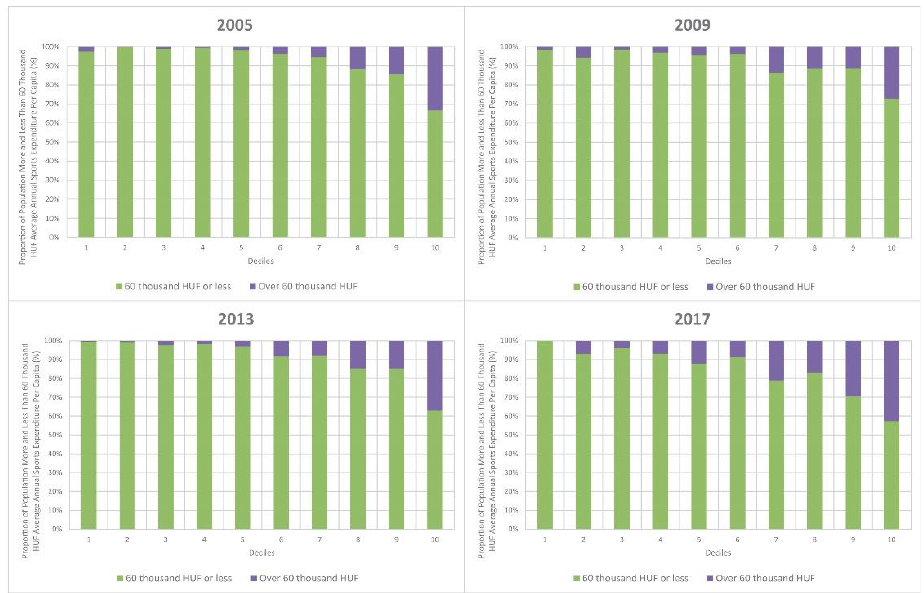
Figure 7. Proportion of population more and less than 60,000 HUF average annual sports expenditure per capita (%). Source: own calculation.